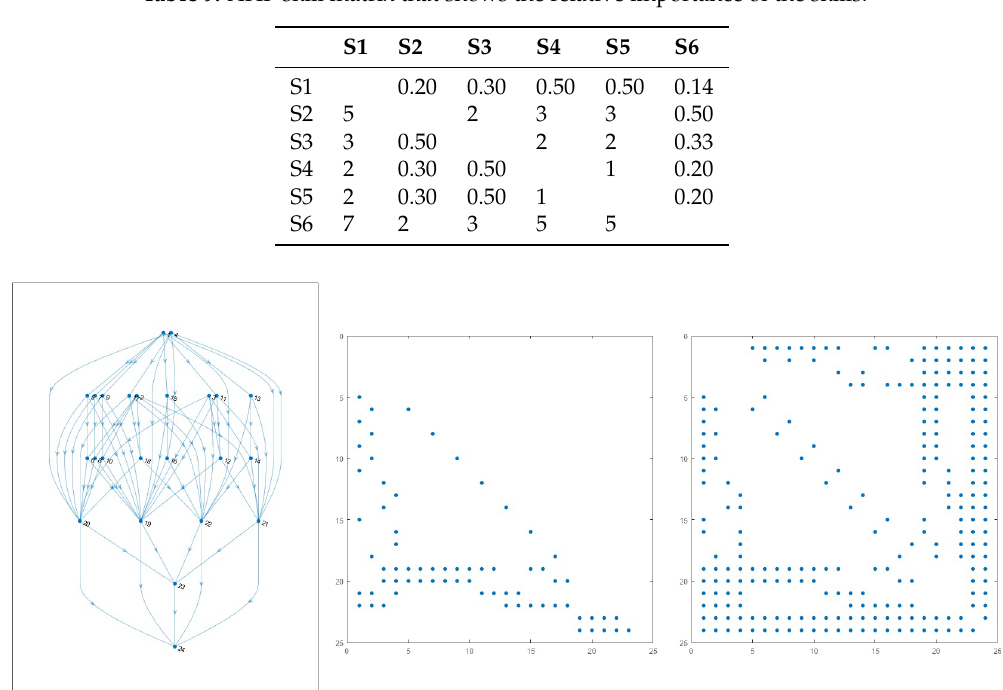
Table 9. AHP skill matrix that shows the relative importance of the skills.